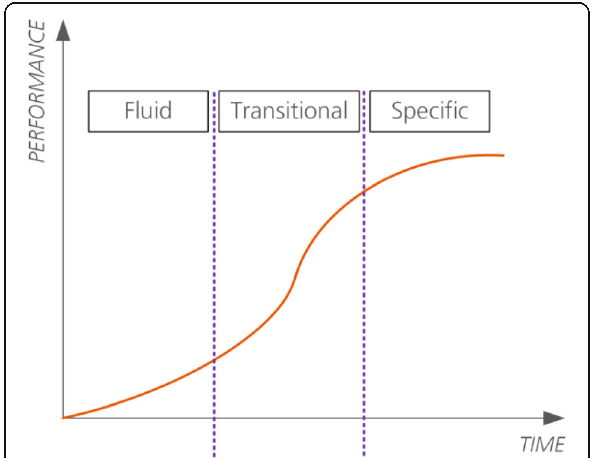
Fig. 4 Typical progress in technology development measured in performance over time. There will be a fluid phase, where performance increases slightly over time, a technology emerges. The transitional phase sees significant increases in performance, before the curve flattens and finally the specific phase, where only specific parameters are improved, maturation of the technology is high. Based on